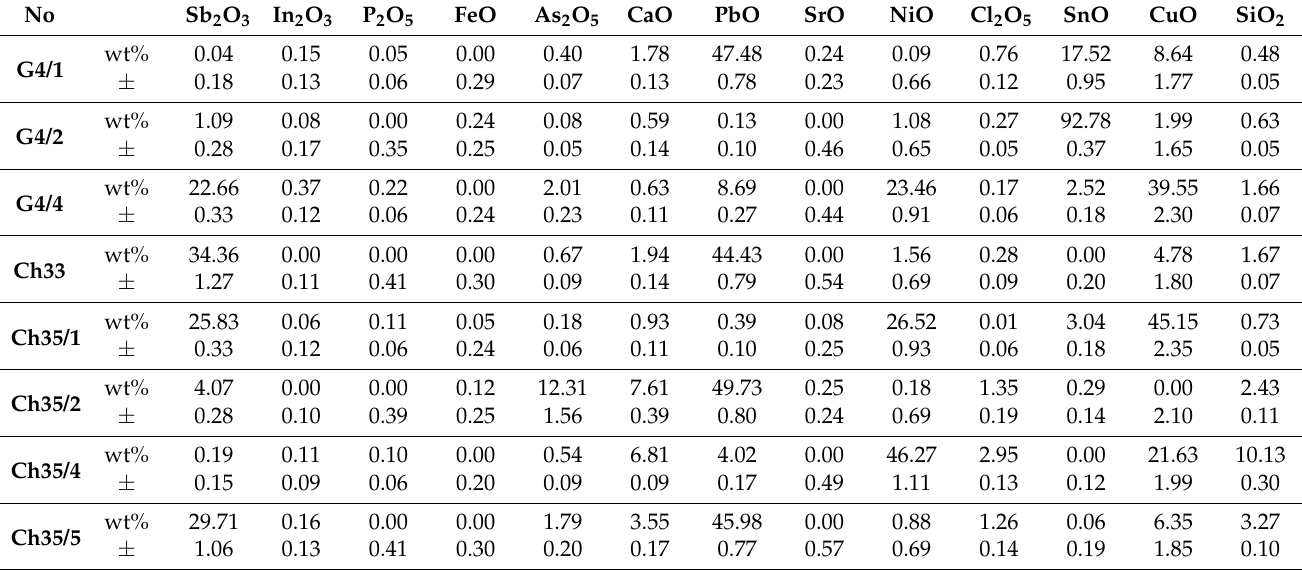
Figure 4. X-ray intensity maps of selected elements in the malachite layer of sample K52: ( a ) angle selective backscattered (AsB) electron image; ( b ) Cu map; ( c ) Pb map; ( d ) Sb map. Table 2. Quantitative elemental analysis of selected Sb-bearing grains in green copper pigments layers (sample G4, Ch33, Ch35) by EDS expressed in wt% oxygen by